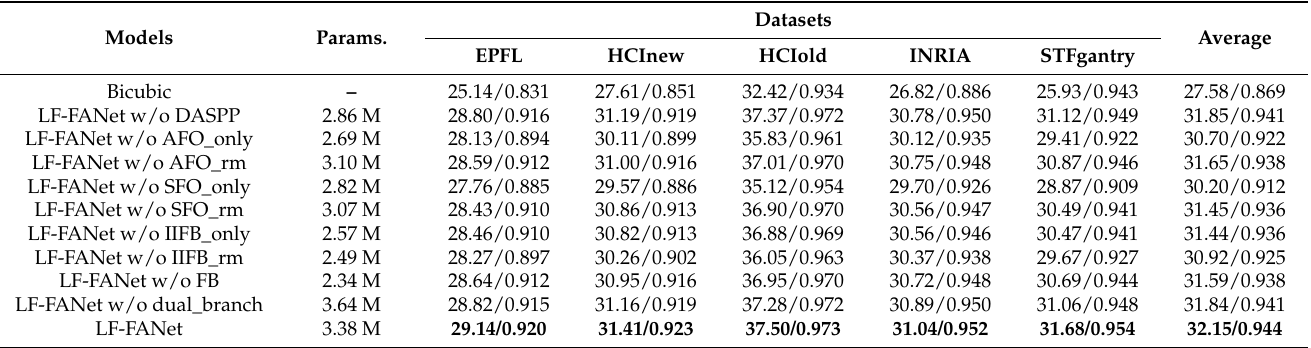
Table 4. PSNR/SSIM values achieved by LF-FANet and its variants for 4 × SR. The best results are in